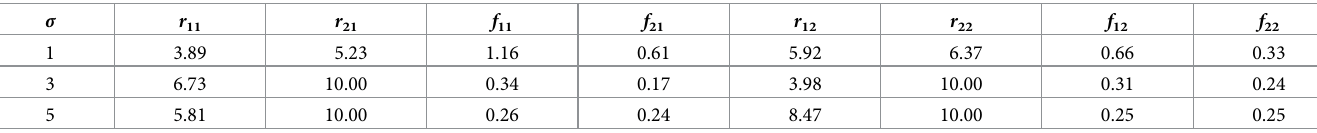
Optimal one-step profile for one fraction of radiation with logistic growth and exponential death. σ is the standard deviation of the initial Gaussian tumour cell density, which starts with 10 7 total cells. r 11 , r 21 , r 12 , r 22 , f 11 , f 21 , f 12 and f 22 are the radii and strengths of the steps in the cytotoxic radiation profiles. N ( t + dt ) is the final tumour cell number at the end of radiation.